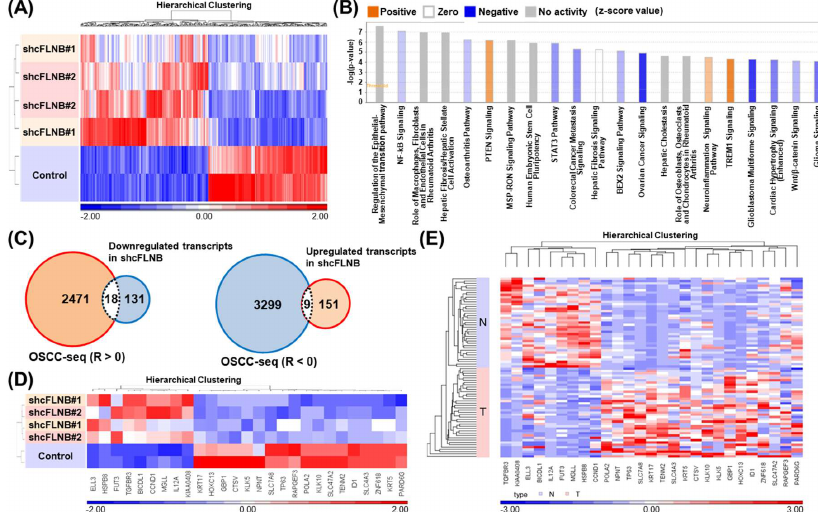
Figure 7. Transcriptome-wide exploration of circFLNB-mediated regulatory network. ( A ) Transcriptome-wide changes in circFLNB knockdown cells were profiled by RNA-seq. Overall profiles of the differentially expressed genes in the control and knockdown groups (as indicated) are represented by the heatmap. The expression values (represented by normalized read counts) are displayed in shades of red or blue (linear scale) relative to the means of all corresponding values within individual experimental groups. Clusters of genes (based on unsupervised hierarchical clustering) are indicated and denoted by their experimental types / conditions. ( B ) Differentially expressed genes (DEGs) were subjected to pathway analysis using the Ingenuity Pathway Analysis (IPA) tool. ( C ) Venn diagrams illustrate the degree of overlap between the circFLNB-correlated genes as shown by OSCC-specimen RNA-seq (OSCC-seq) and those differentiated expressed in the circFLNB knockdown experiments. To identify potential downstream targets of circFLNB, positively-correlated genes (R > 0) were intersected with downregulated DEGs in circFLNB knockdown (left; n = 18), while inversely correlated genes (R < 0) were intersected with upregulated DEGs (right; n = 9). ( D , E ) The distribution of the expression profiles of the 27 intersected genes uncovered in ( C ) are shown as heatmaps in the circFLNB knockdown experiments ( D ) and the OSCC samples from the 39 patients ( E